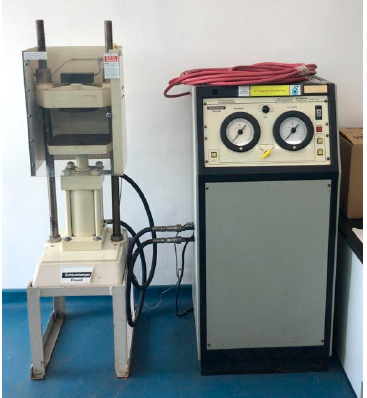
Figure 1. API Compressive Strength Tester.